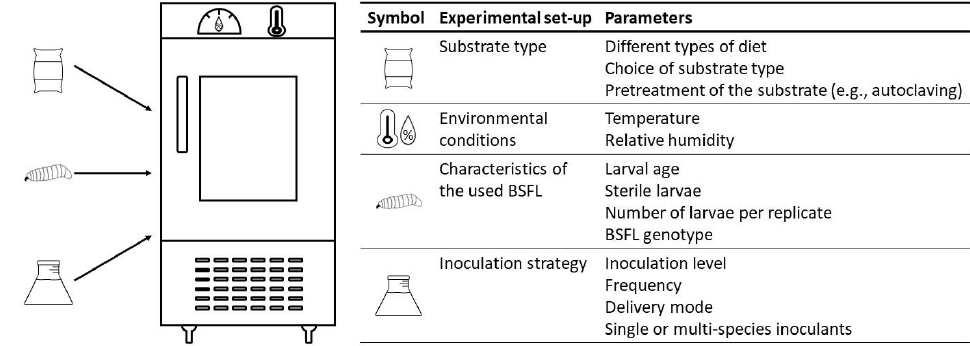
Figure 1. Overview of the set-up of an inoculation trial and a range of parameters that must be defined.